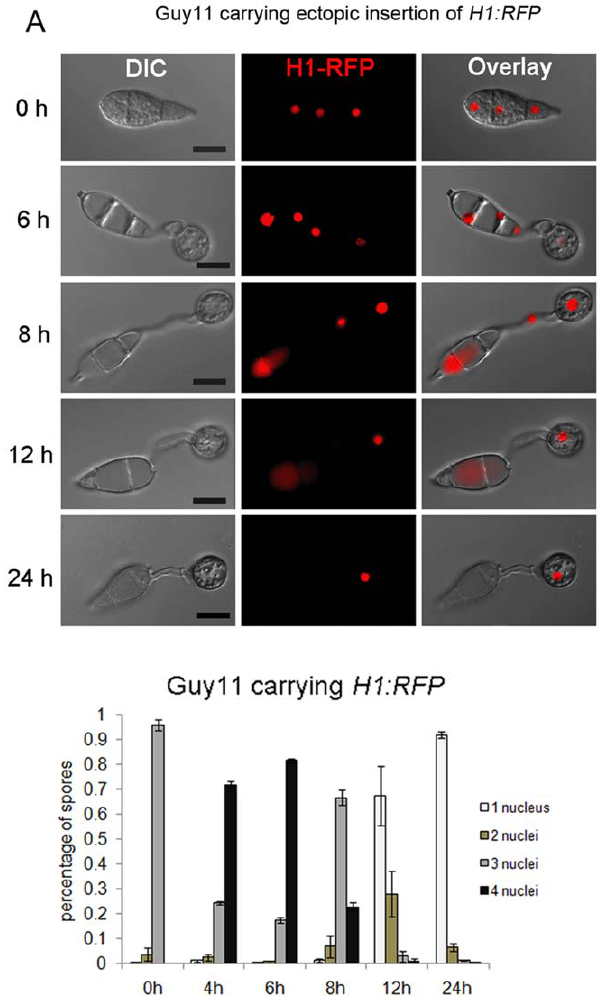
imaging experiment showing nuclear division and nuclear degenera- tion during appressorium development in M. oryzae . Guy11 conidia expressing H1:RFP were examined by epifluorescence microscopy at indicated time points during appressorium development. Lower panel: bar charts showing the percentage of spore germlings in Guy11 containing between 0 and 4 nuclei (mean 6 SD, n . 100, triple replications) during a timecourse of appressorium development. Scale bar=10 m